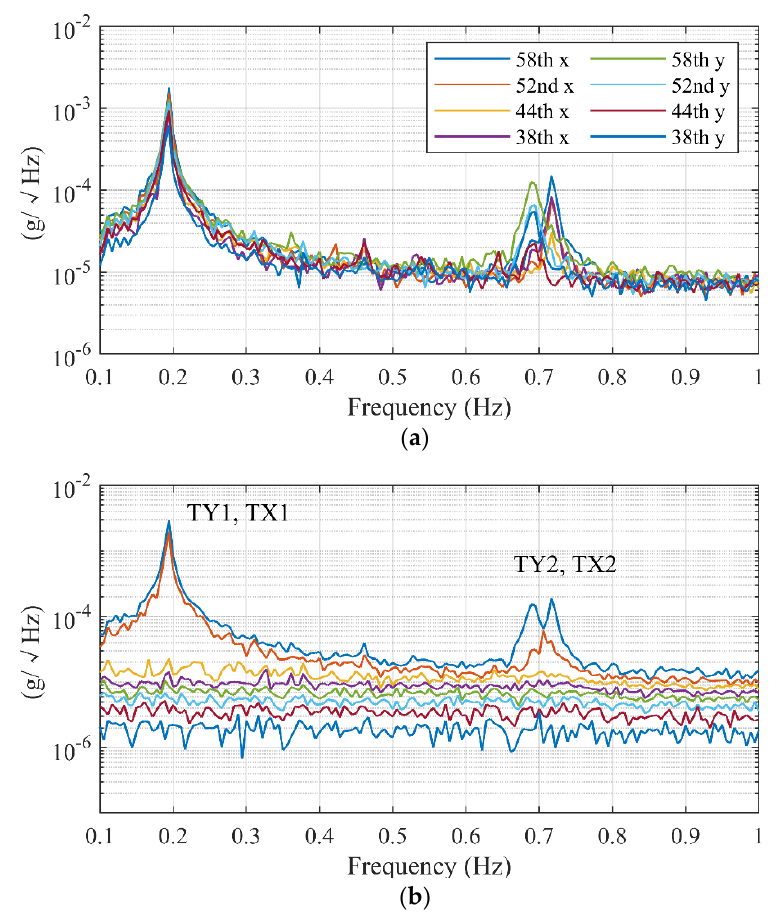
Figure 10. PSD and SV spectra of a 30 min period: ( a ) PSD; ( b ) SV.